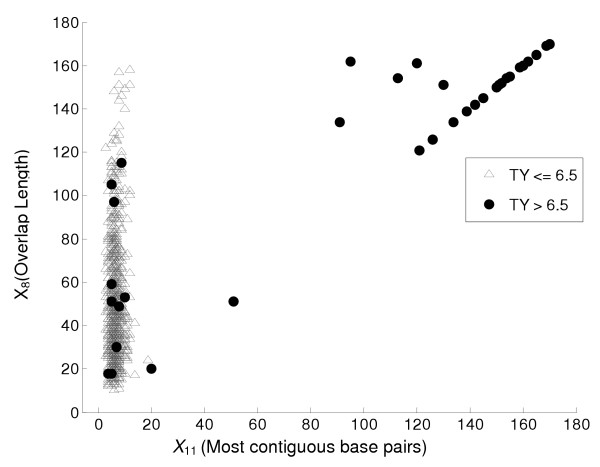
Representation of hybridization intensities with respect to the most contiguous base pairs and overlap lengths. Solid circles show strong hybridization intensities (TY > 6.5), while open triangles indicate low intensities (TY ≤ 6.5).